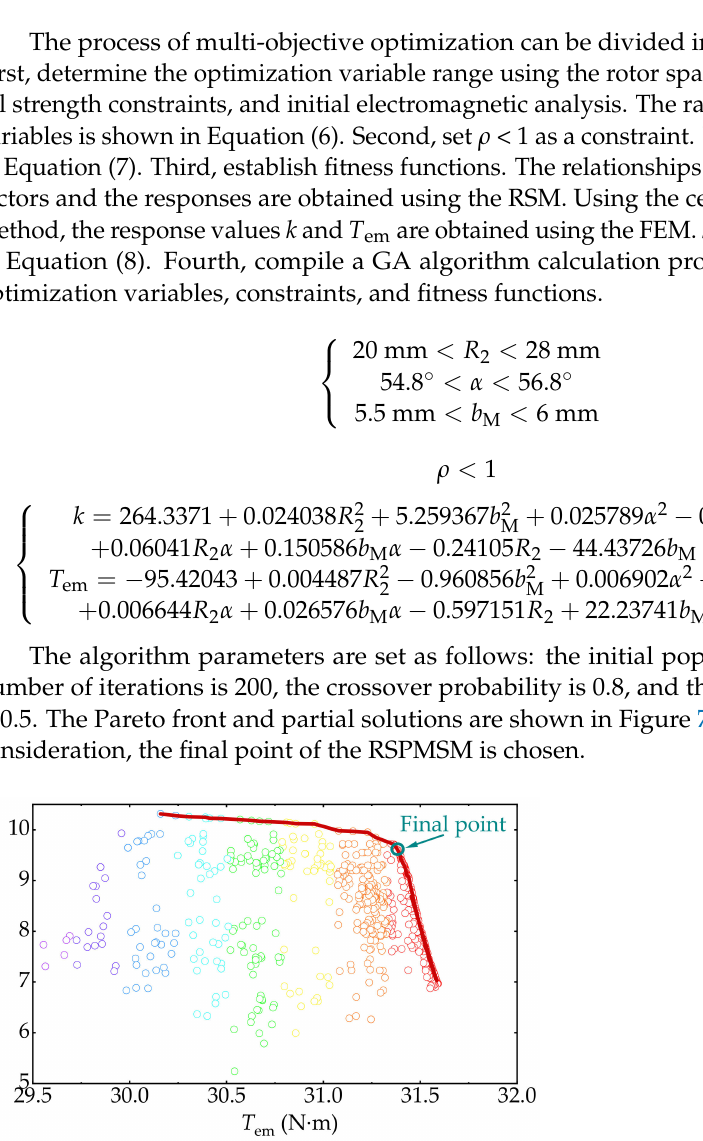
Figure 7. The results of multi-objective optimization.